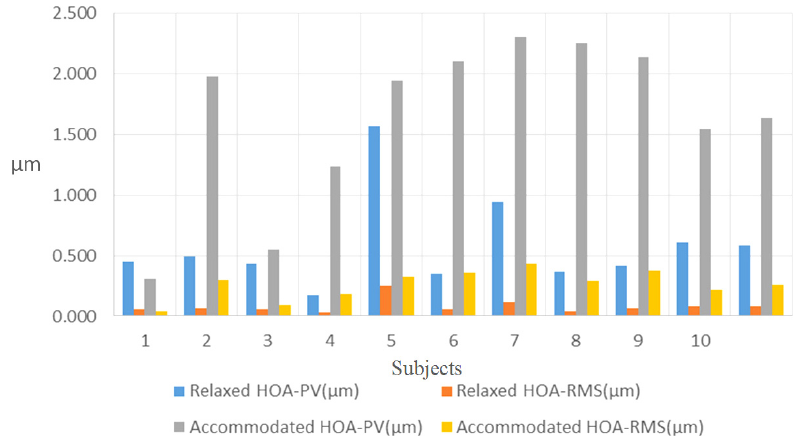
Fig. 3. Changes in 10 volunteers' high-order wavefront